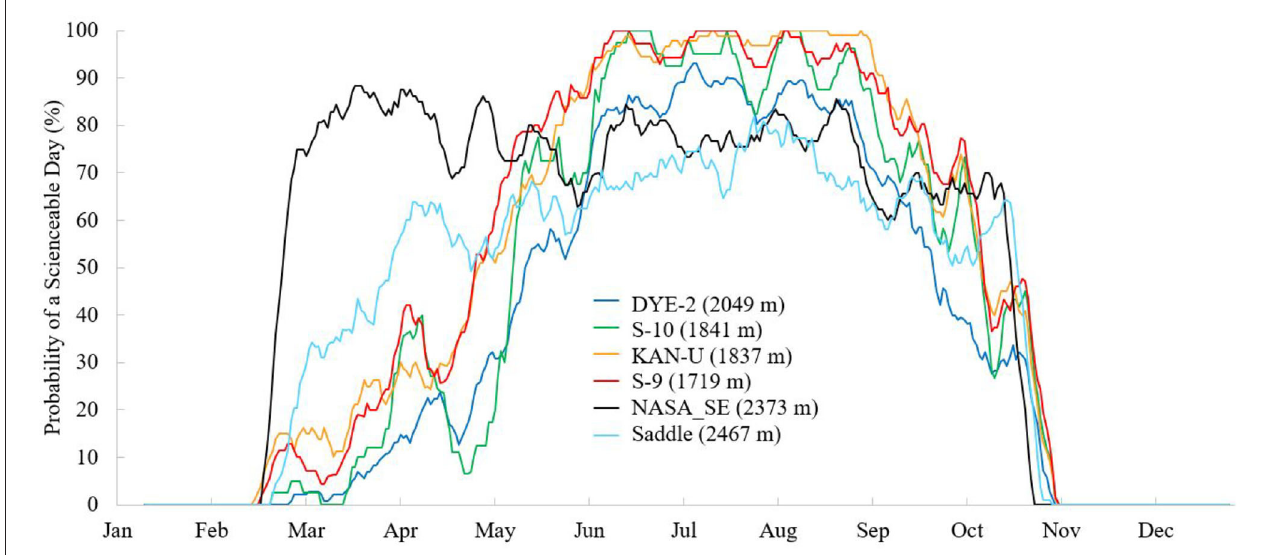
FIGURE 3 | The probability of a scienceable day for each day of the year for the six field sites shown with 10 day moving averages using data from 2010 to 2016. Values next to site names represent the elevation of the weather station in m above sea level. [Asa: ADD: Data availability between 2010 and 2016 varied between the stations].